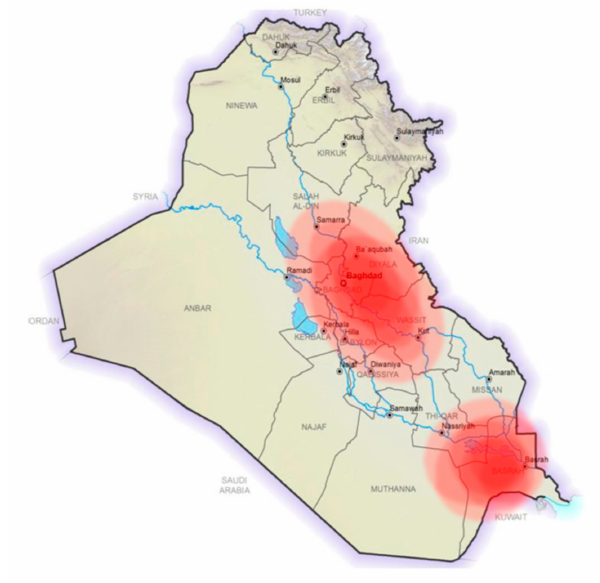
Figure 3. Map of the